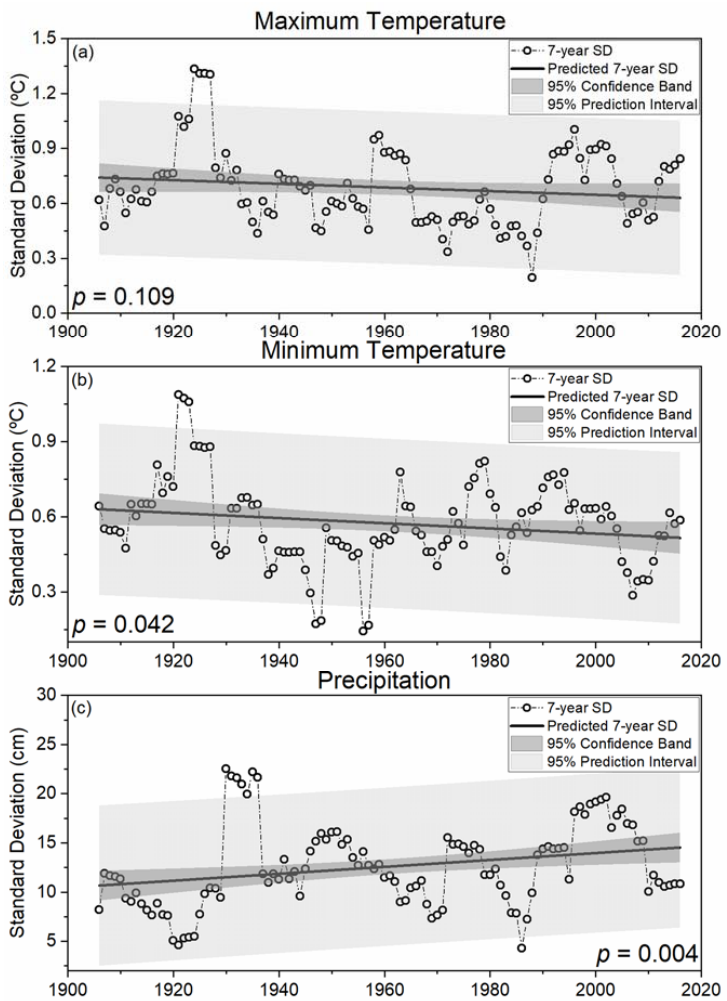
Figure 3. Seven-year standard deviations of state averaged ( n = 18) maximum temperature (( a ); °C), minimum temperature (( b ); °C), and total annual precipitation (( c ); cm) for West Virginia, USA.